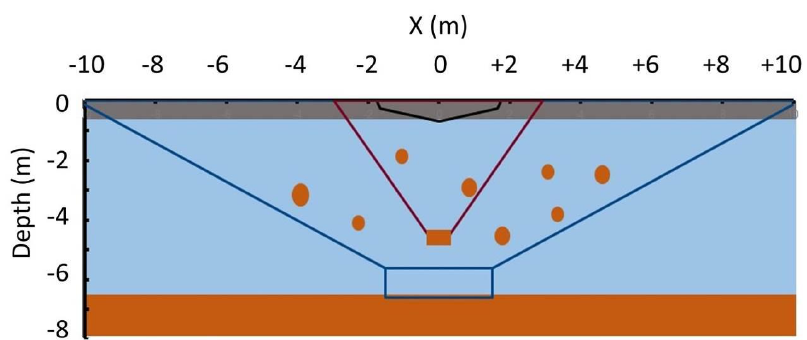
Figure 6. Cross-sectional view of the three excavations: 2017 (black line), 2018 (red line), and 2019 (blue line), and the three layers: peat (gray), clay-sand (blue), and granite (brown). Brown ellipsoids represent the two granite boulders found to be distributed within the clay-sand volume of the 2018 excavation and the ten found in the 2019 excavation. The brown rectangle shows the location of the only ensemble of fractured rock found in the excavations.